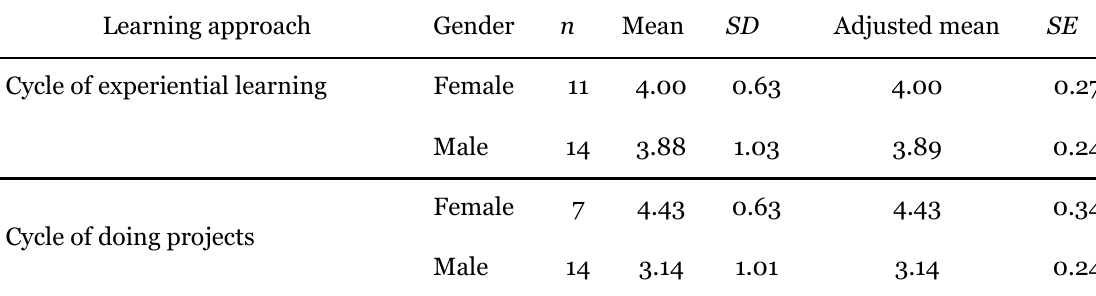
Descriptive Statistics Results After the Simple Main-Effect Analysis in VUI